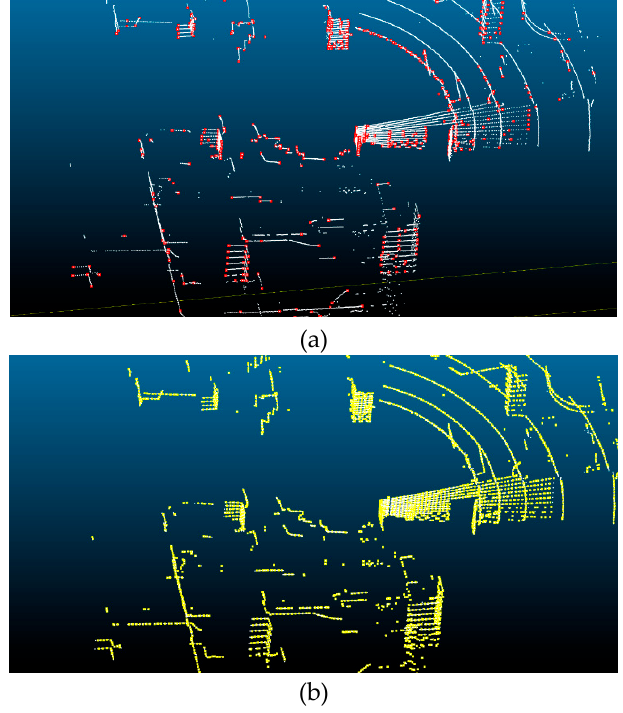
Figure 3. Demonstration of feature extraction: ( a ) edge points (red), ( b ) planar points (yellow).